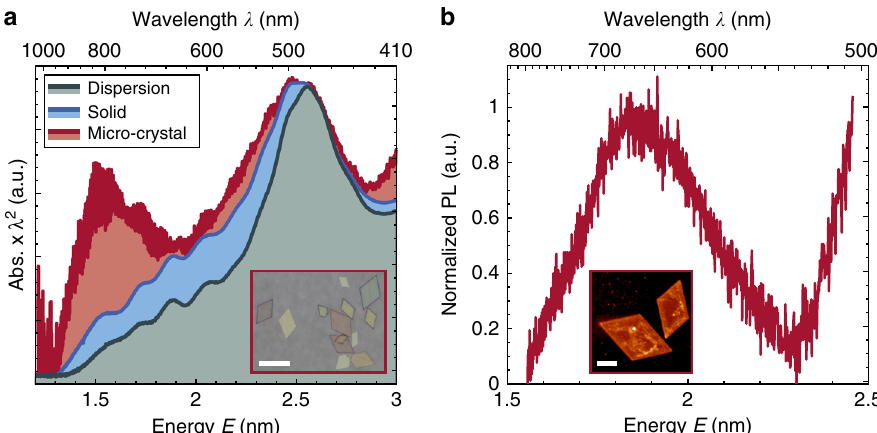
Fig. 3 Optical properties of Au 32 -NCs and microcrystals. a Absorbance spectra of Au 32 -NCs dispersed in hexane (green), in a thin fi lm (blue), and in microcrystals (red) on glass. Individual microcrystals show enhanced absorption at 800 nm (1.55 eV), corresponding to the HOMO-LUMO transition. The prominent absorption peak at 481 nm (2.58 eV) for dispersed NCs, is slightly red-shifted to 483 nm (2.51 eV) and broadened for Au 32 -NCs in thin fi lms and microcrystals. All spectra are normalized to the prominent peak at 481 nm. The inset shows an optical micrograph of individual microcrystals on a glass substrate. Scale bar: 15 µ m. b Photoluminescence (PL) spectrum of an individual microcrystal shows a broad emission peak at around 670 nm. The inset displays the luminescence of two microcrystals upon excitation with 488 nm. Scale bar: 5 µ